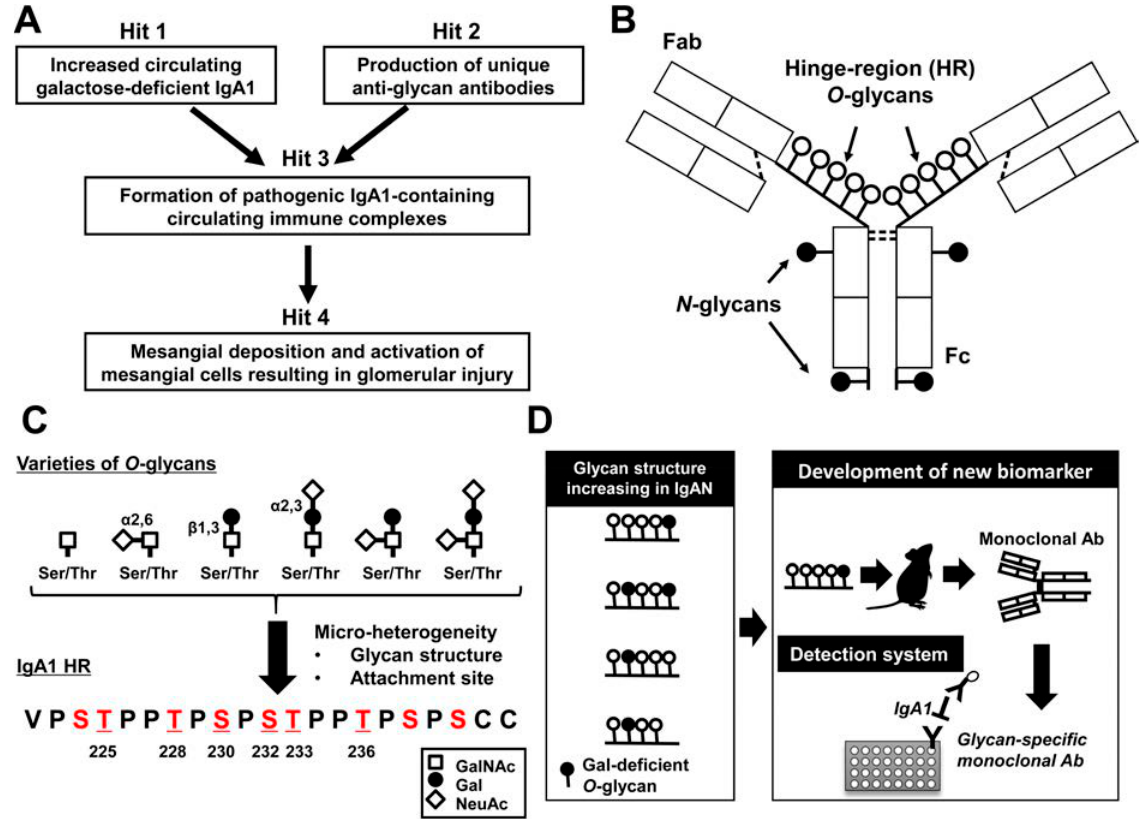
Figure 1 Background of the study. A. Hypothesis of the pathogenesis of IgAN. 7,8 Serum levels of abnormally glycosylated IgA1 are increased in patients with IgAN (Hit 1). This aberrantly glycosylated IgA1 is recognized by anti-glycan antibodies (Hit 2). Then, IgA1-containing circulating immune complexes are formed (Hit 3). Finally, the immune complexes are deposited to the mesangium followed by activation of mesangial cells resulting in glomerular injury (Hit 4). B. Serum IgA1. Serum IgA1 possesses a 19-amino acid hinge region (HR) with clustered O -glycans. A HR with four to five O -glycans is the dominant structure. C. The variants of O -glycans in serum IgA1. N -acetylgalactosamine (GalNAc) attaches to the Ser/Thr residues of the HR. The O -glycan chain can be extended by attachment of galactose (Gal) to the GalNAc residues, and GalNAc or Gal can be sialylated. The Gal-deficient O -glycans present in elevated amounts in patients with IgAN are represented by the structure shown at the far left. The HR is a Pro-rich segment with nine possible sites for O -glycan attachment, shown in red. Underlined Ser and Thr residues are the O -glycosylation sites that have been previously reported. 13,14,16 Thus, IgA1 HR O - glycoforms have the potential to show wide diversity in terms of their glycan attachment sites and glycan structures. D. Mass spectrometry-based approach for the development of biomarkers in IgAN. After HR O -glycan structures that are only increased in patients with IgAN are identified by our mass spectrometry-based protocol, using these specific HR O -glycoforms as novel biomarkers with detection by monoclonal antibodies will provide a diagnostic method with higher sensitivity and specificity than the existing